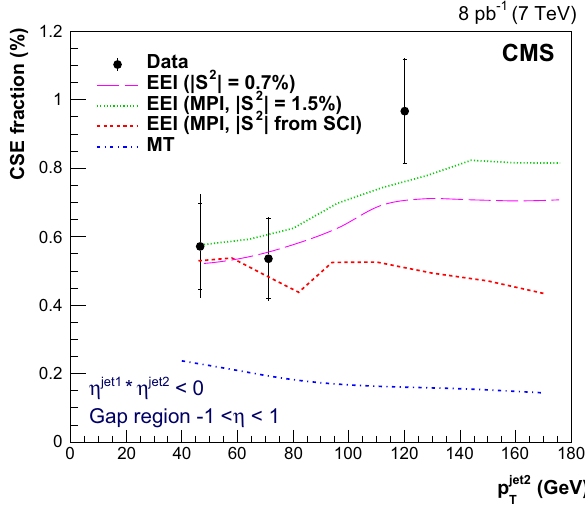
Fig. 9 Fraction of dijet events with a central gap ( f CSE ) as a function √ s = 7 TeV, compared to the predictions of the Mueller of p jet2 at T and Tang (MT) model [21], and of the Ekstedt, Enberg, and Ingelman (EEI) model [22,23] with three different treatments of the gap survival probability factor | S | 2 , as described in the text. The results are plotted at the mean value of p jet2 in the bin. The inner and outer error bars T represent the statistical, and the statistical and systematic uncertainties added in quadrature,